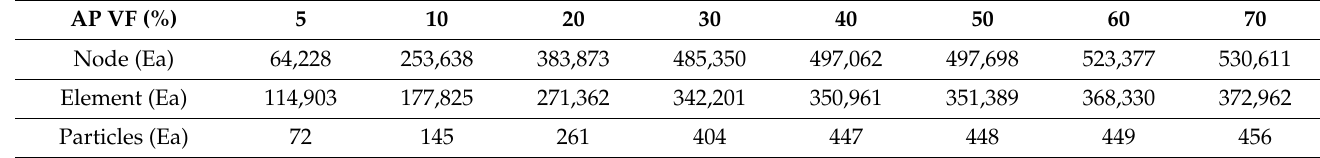
Figure 3. Mesh modeling with AP volume fraction (VF). ( a ) 5%. ( b ) 10%. ( c ) 20%. ( d ) 30%. ( e ) 40%. ( f ) 50%. ( g ) 60%. ( h ) 70%. Table 2. Boundary conditions per volume fraction (VF).